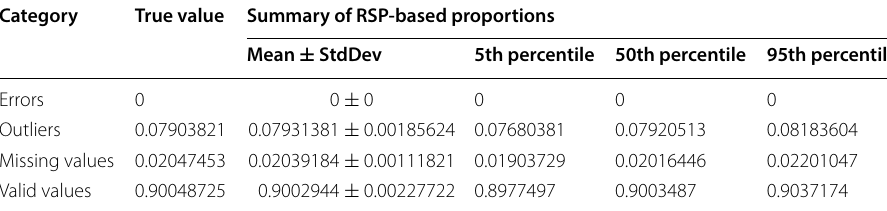
RSP-based proportions were calculated from a sample of RSP blocks ( g = 10 )